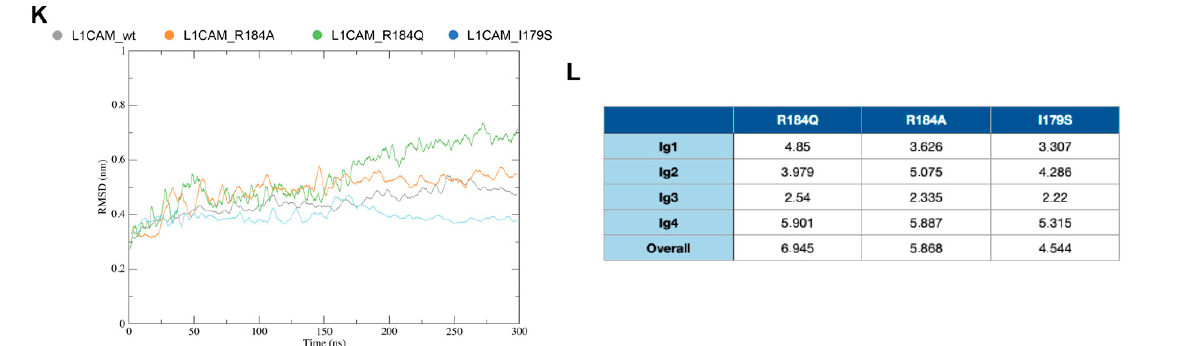
Figure 4. Molecular dynamics simulations of L1CAM and its mutants. Comparison of models after 300 ns simulations with wt ( A – C ) side view, ( D – F ) top view (orange: L1CAM_R184A, green: L1CAM_R184Q, light blue: L1CAM_I179S, white: L1CAM wild type). ( G – J ) Structural variation of Ig2 domains of WT, R184A, R184Q, and I179S mutants, respectively. ( K ) Variation of the root mean square deviation (RMSD) of the Ig2 domain during the simulation. ( L ) All-atom RMSD between mutants and wild type final structures. All data are reported in Å.